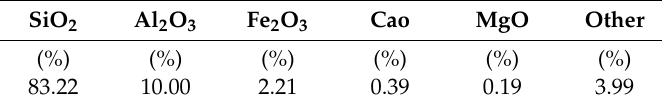
Table 5. Chemical composition of the silica powder.